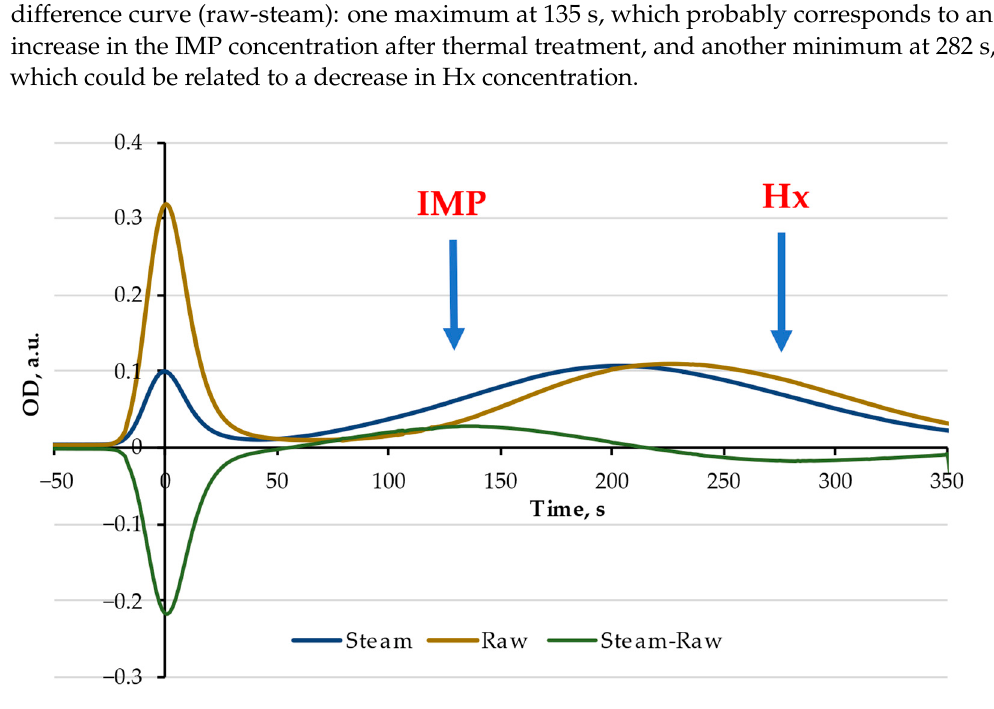
Figure 9. The low-field region of 1 H NMR spectra of Alaska Pollock samples: ( a ) before thermal treatment, ( b ) after steam cooking at 100 ° С for 60 min, and ( с ) after steam cooking with added IMP and Ino. 4. Discussion The results obtained for in-house-validation by TVB-N and VFA standard methods show that the FPMLC sensor can be used equally successfully to evaluate the freshness of both fish and animal meat. This conclusion is not surprising, since in both cases, freshness in this study is determined by the formulas (2) and (3) based on the main metabolites of ATP as the variables. These metabolites are absolutely the same in fish and meat, which reflects the common features of the ATP post-mortem catabolism.